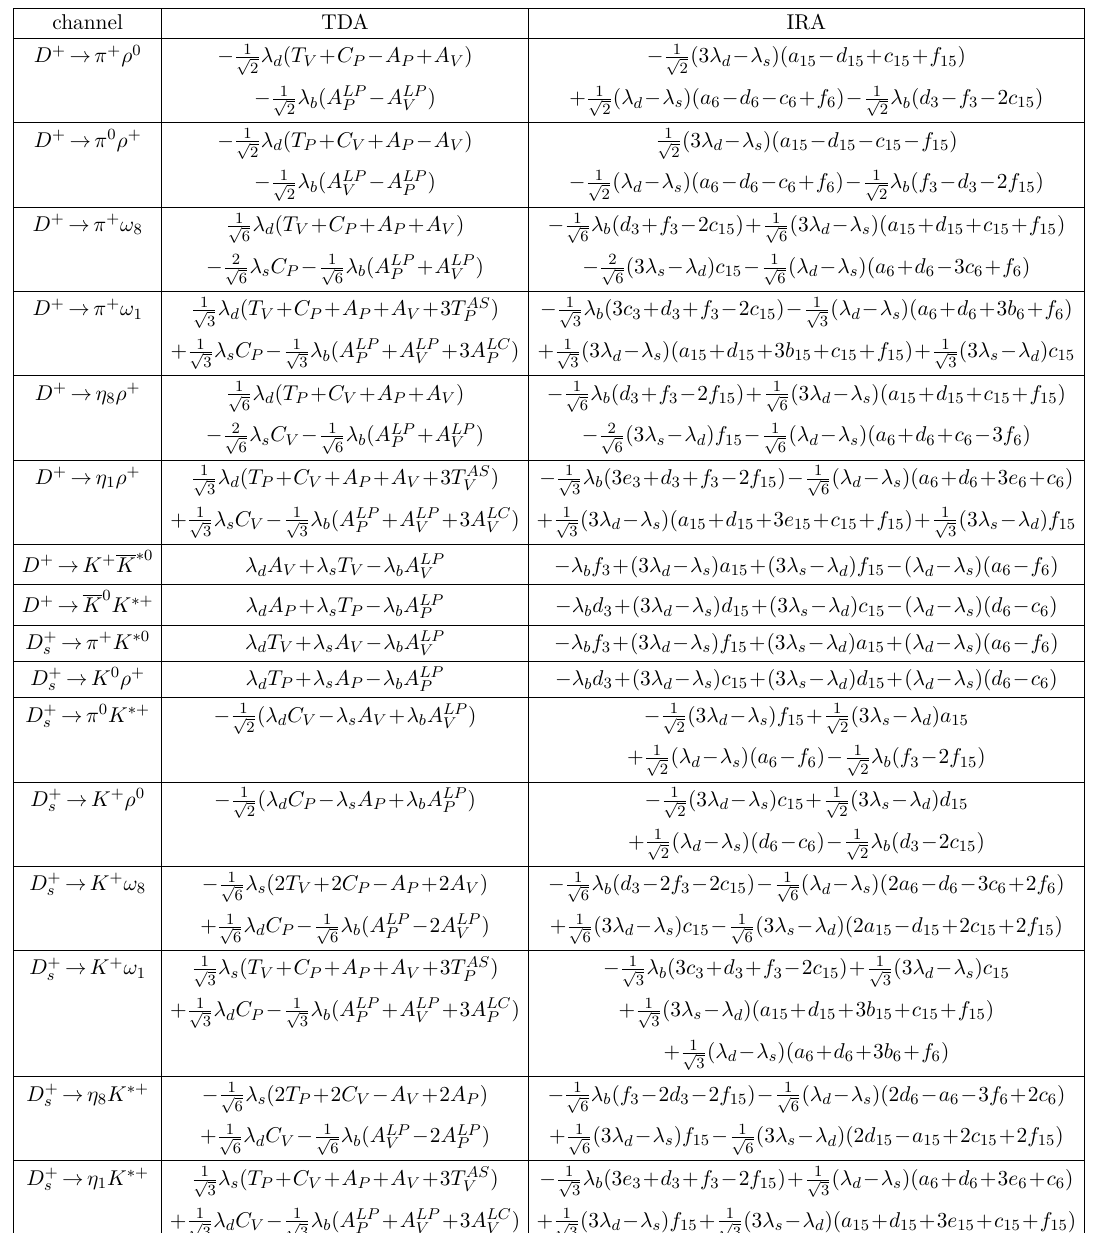
Table 7 . Decay amplitudes of the singly Cabibblo-suppressed D +